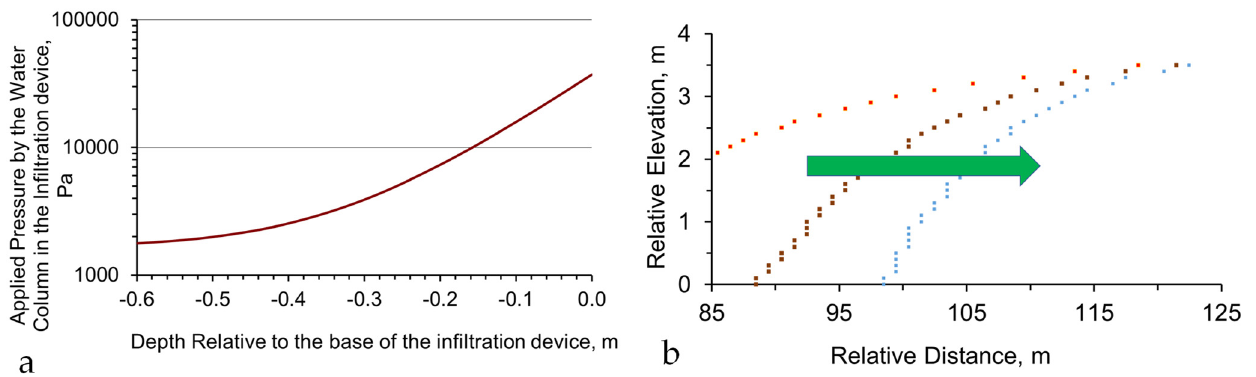
Figure A4. Pressure Losses associated with infiltration: ( a ), example of pressure loss with depth below a 4 m water column in an infiltration device; ( b ), example impact of lateral pressure loss on the lateral extent of a groundwater mound. Green arrow indicates the direction of increasing pressure loss. Red dots: pressure loss is low (x% m − 1 ); brown dots: pressure loss is higher ((x + y)% m − 1 ); blue dots: pressure loss is even higher ((x + y + z)% m − 1 ).